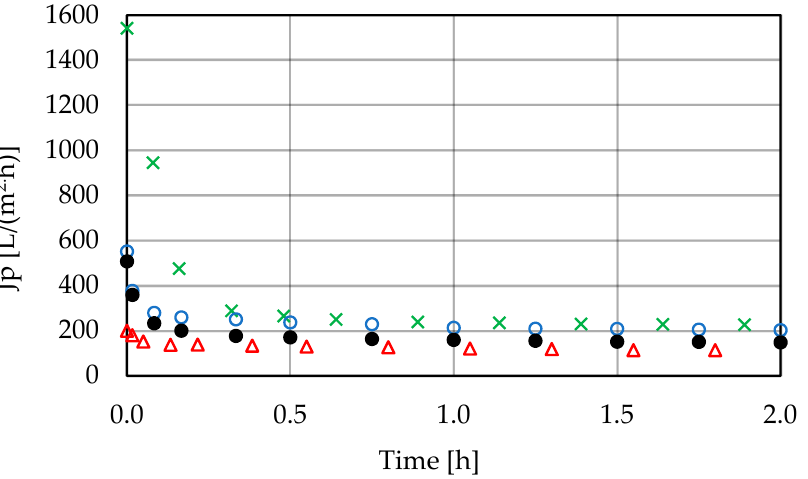
Figure 2 . Change in permeate flux during low-pressure filtration (T = 25 °C, w = 4 m/s, Δ P = 0.2 MPa); × , Berghof 0.03 mm; o, Katmaj 500 kDa; ∆ , Burkert CUT 50 kDa; • , PCI 20 kDa. Points represent the average of five measurements.